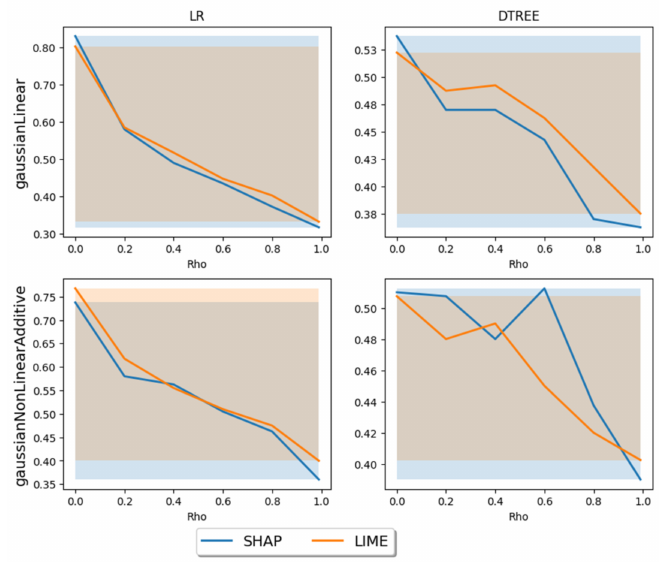
Figure 5. The dependence of the monotonicity metric on the correlation coefficient. The results of calculating the incompleteness metric are shown in Figure 6.